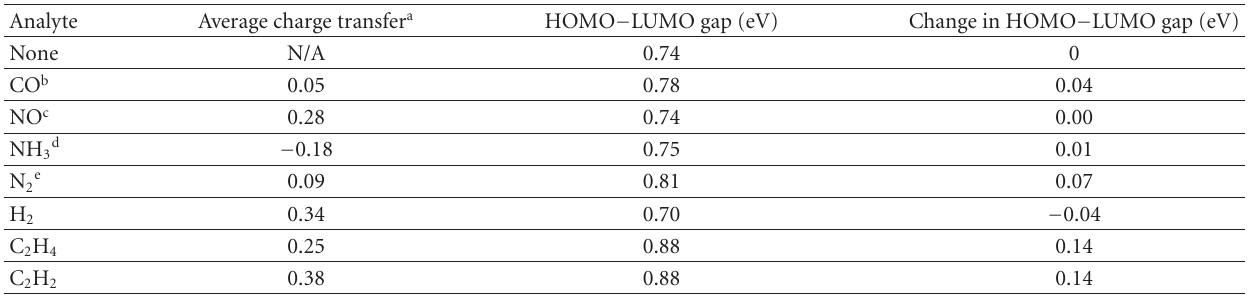
Table 9: Charge transfer and HOMO − LUMO gap data for nanotube-adsorbate complexes with side-on binding motif [113, 114]. Analyte Average charge transfer a HOMO − LUMO gap (eV) Change in HOMO − LUMO gap (eV) None N/A 0.74 CO b 0.05 NO c